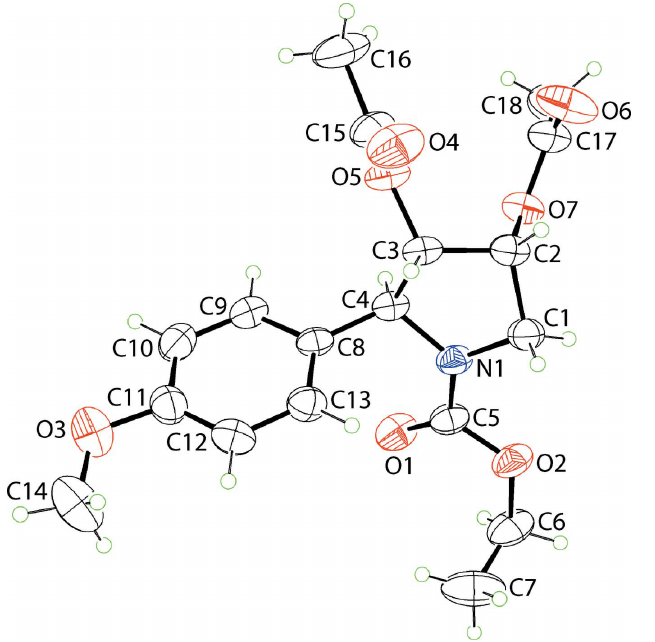
Figure 1 The molecular structure of (I), showing the atom-labelling scheme and displacement ellipsoids at the 35% probability level. The minor components of the disordered residues are